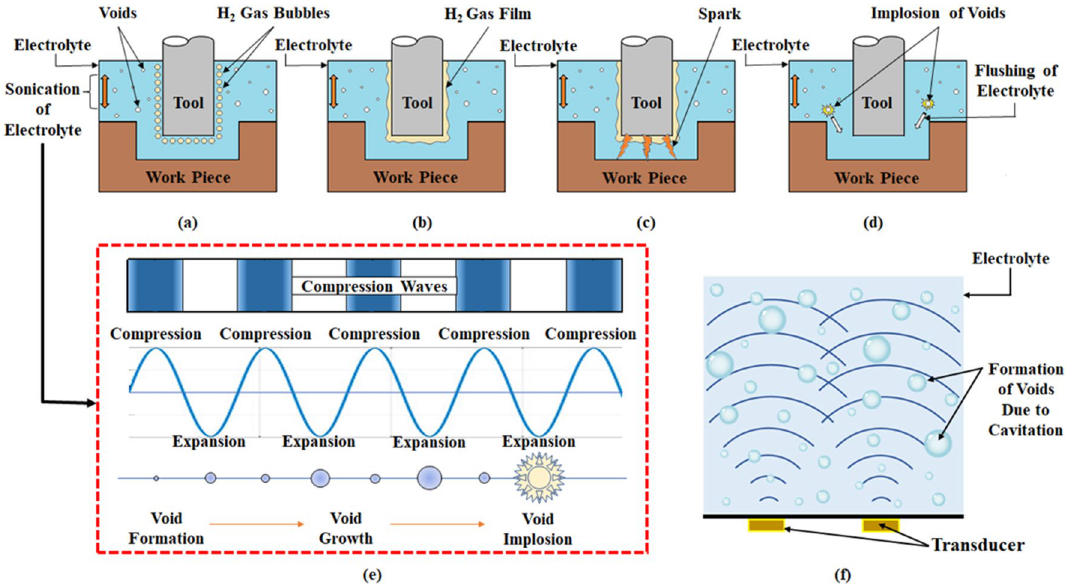
Figure 5. Material removal mechanism of ES-µ-ECDM system ( a ) formation of gas bubbles ( b ) formation of gas film thickness ( c ) occurance of spark ( d ) electrolyte flushining due implosion of the voids ( e ) gradual growth and void implosion phenomenon ( f ) formation of voids due to